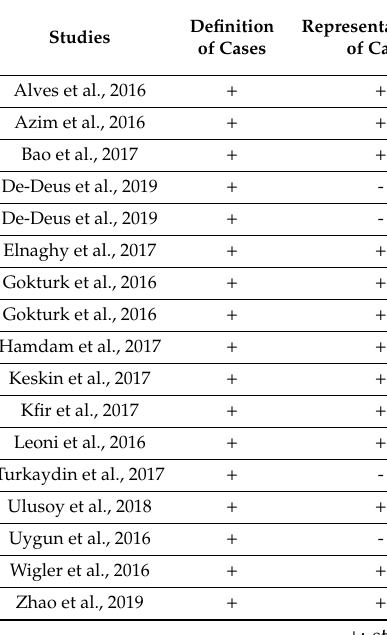
Table 1. Quality assessment of the included studies.